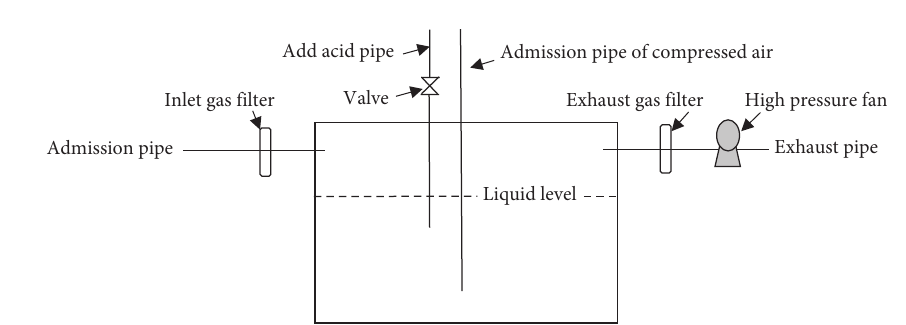
Figure 5: Schematic diagram of ventilation system for temporary acid adding process in storage tank.